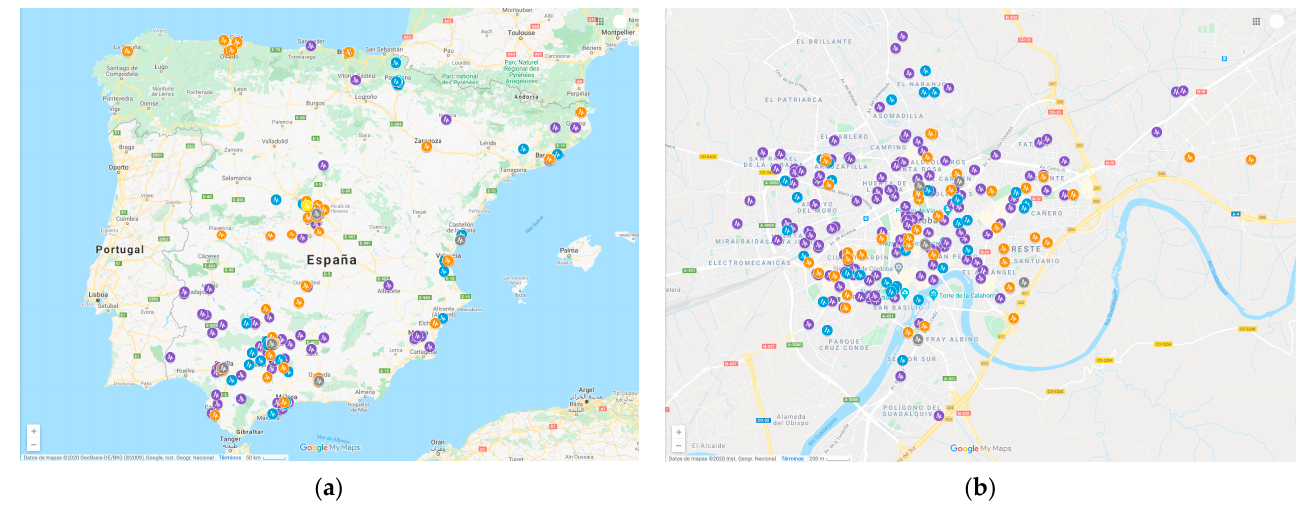
Figure 2. GPS positions of the results in Spain: ( a ) purple for lockdown, grey for phase 0, blue for phase 1, yellow for phase 2 and red for phase 3; ( b ) detail of results for questionnaires in Córdoba: purple for lockdown, grey for phase 0, blue for phase 1.